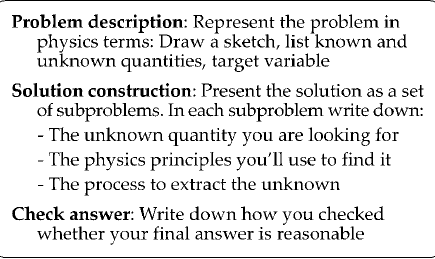
FIG. 2. The pre (quiz 7) problem used in a self-diagnosis task (written by the University of Minnesota [22]).